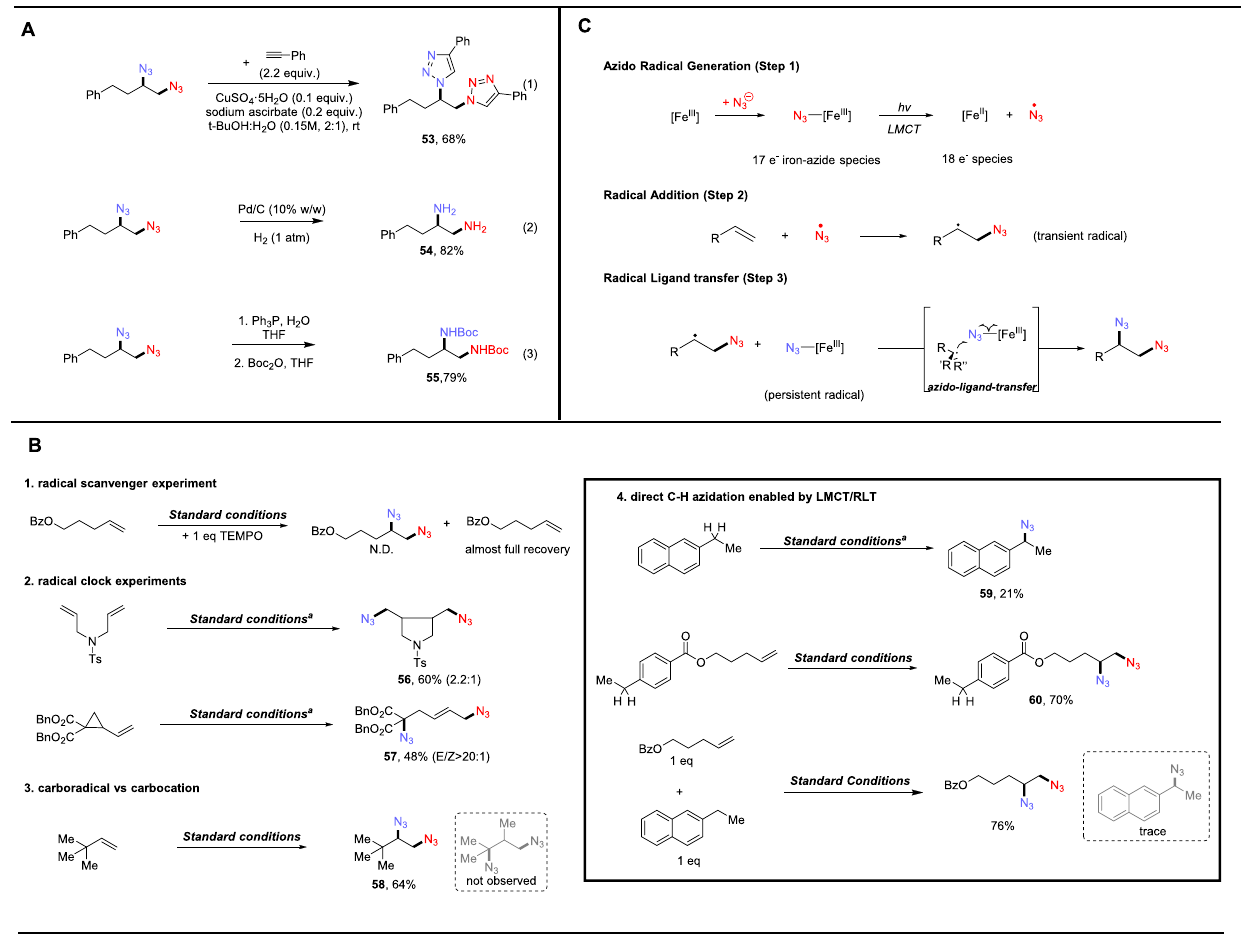
Fig.5|Mechanisticstudiesandproposedpathway.A Derivatizationofdiazides. B Mechanismstudies. C Proposedpathway(azidoradicalgeneration → radicaladdition → radical ligand